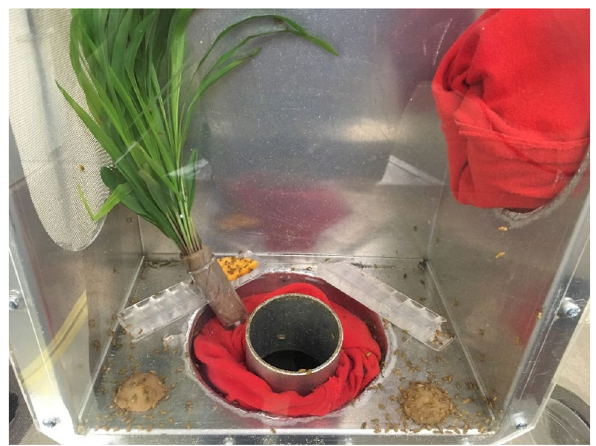
Figure 6. Corn bundle, squash, diet, and water source provided in adult emergence